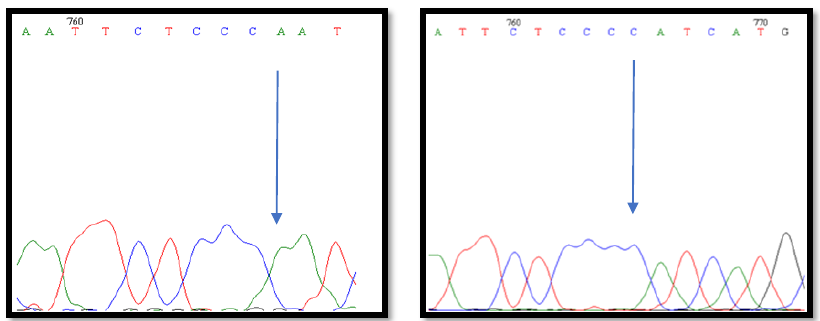
Figure 2. HRM genotyping results.